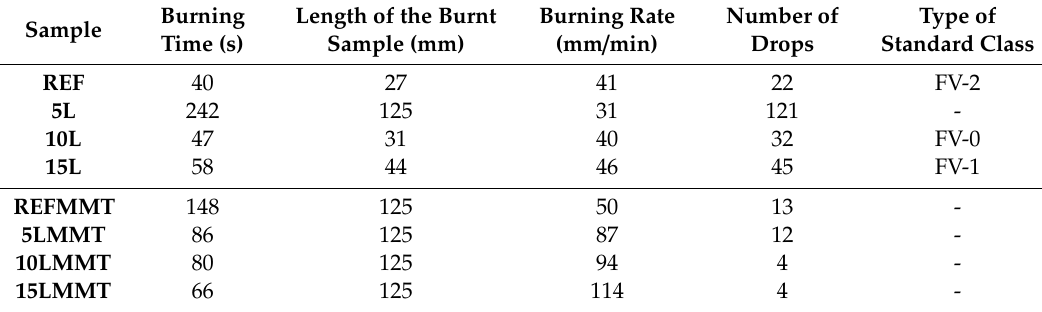
Table 4. Results of the UL-94 combustion carried out in a vertical position (VB) for the composites covered by using the LbL